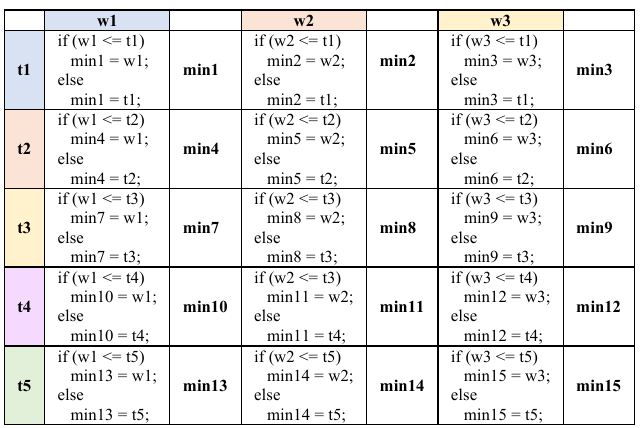
Figure 5. Representation of the algorithm for the fuz_dhl module corresponding to relative humid- ity (RH) fuzzification.